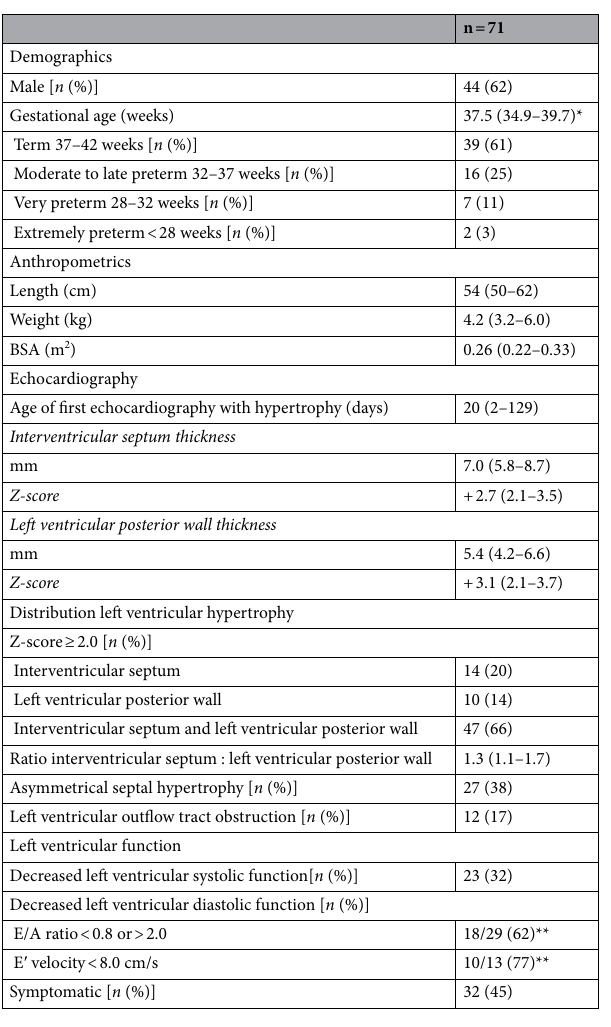
Table 1. Baseline. Data are presented as median with quartiles 25–75. Where appropriate, values are presented as number of patients with percentages. *7 missing; **Only in cases with thickening of both interventricular septum & left ventricular posterior wall if this could be measured